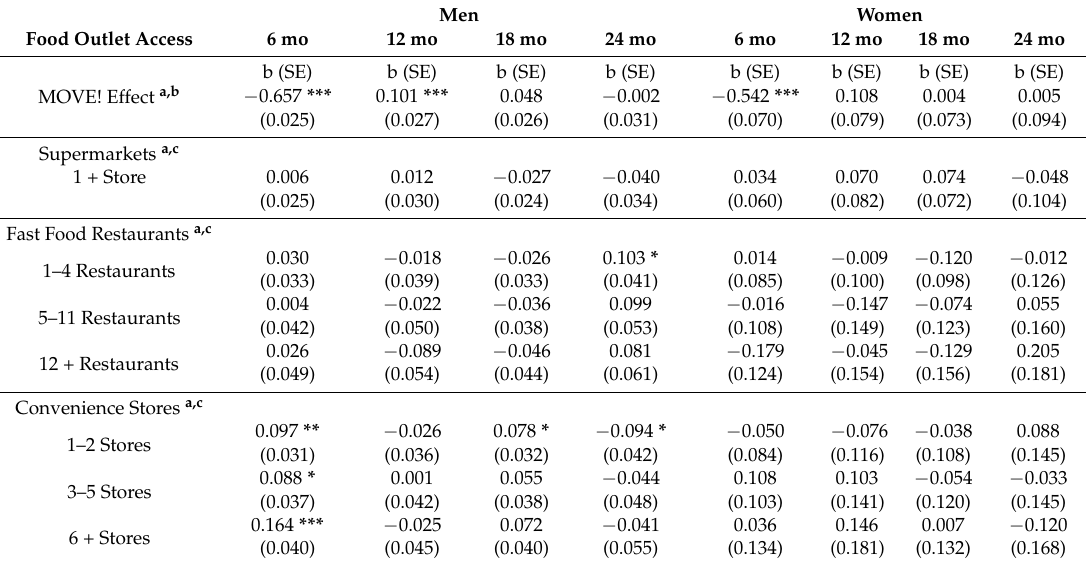
Table 2. MOVE! effect on longer-term incremental BMI change at 12, 18, and 24 months (mo) by food outlet